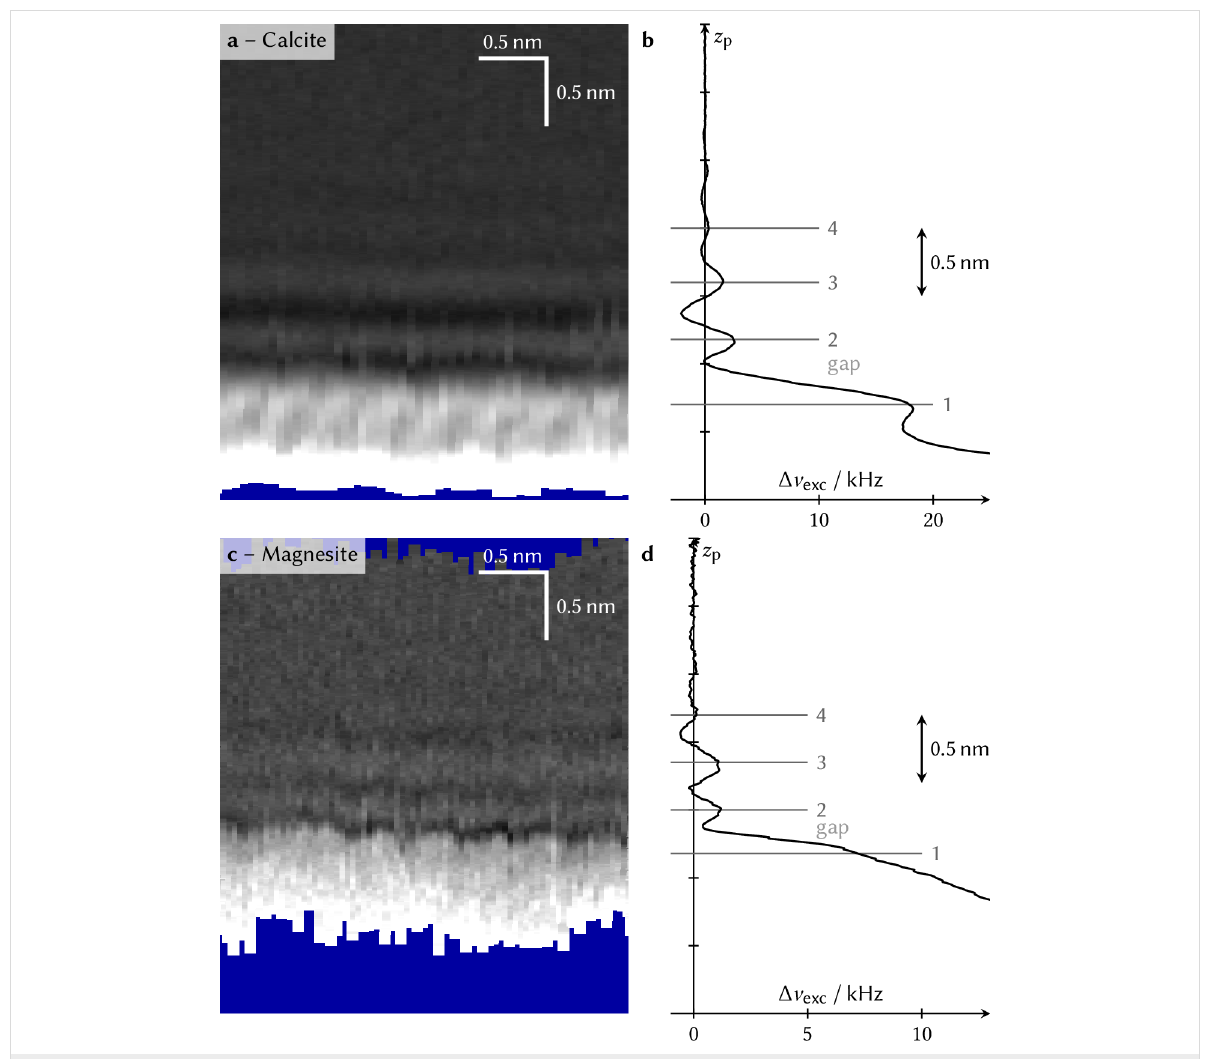
Figure 1: Vertical slice of the frequency shift at the calcite–ethanol interface (a) and at the magnesite–ethanol interface (c). The graphs on the right (b) and (d) show the average of all profiles shown in the slice. In all cases, the frequency is shown as a function of the z -piezo displacement z p . The black/white color scale ranges from approximately − 5 kHz to 27 kHz for calcite and from approximately − 5 kHz to 15 kHz for magnesite. The vertical scale bar in (a) and (c) equally applies to the profiles in (b) and